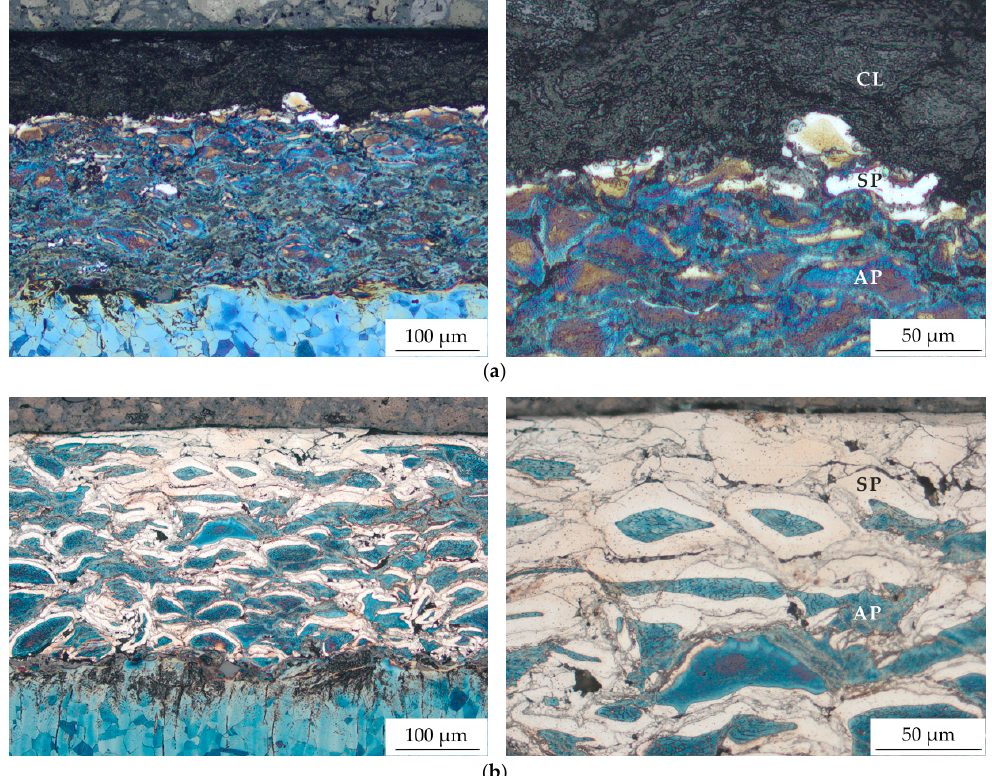
Figure 2. Optical-microscopic images of a Beraha II-etched AISI 316L HVOF coating in as-sprayed